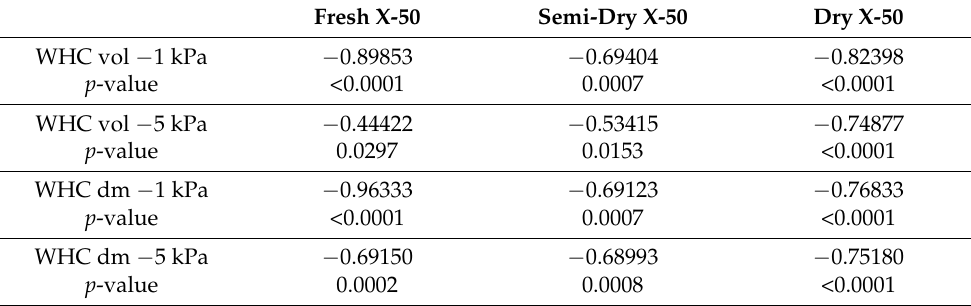
Table 2. Correlation coefficients and their p -values of WHC and X-50. Fresh X-50 Semi-Dry X-50 Dry X-50 WHC vol − 1 kPa −